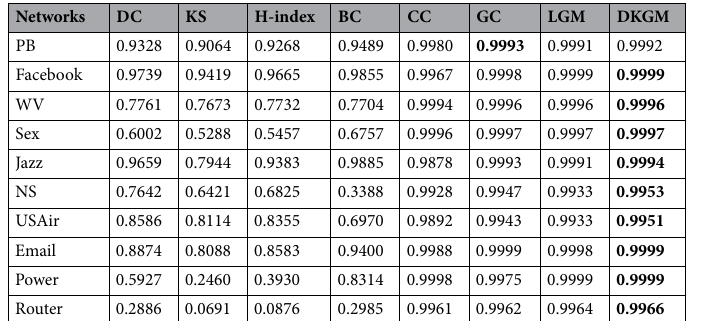
Table 9. The monotonicity of node ranking list produced by different algorithms, the best algorithm for each network is emphasized by bold.